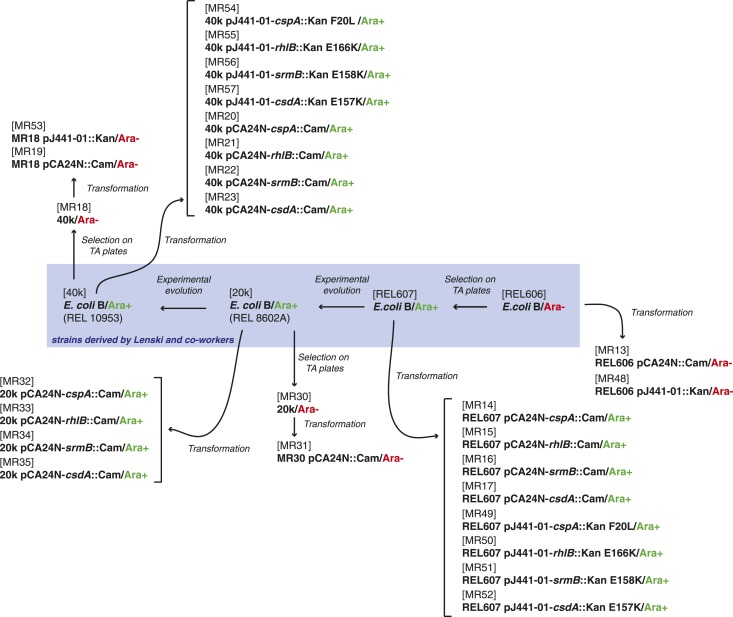
Relationship between REL606-derived strains.